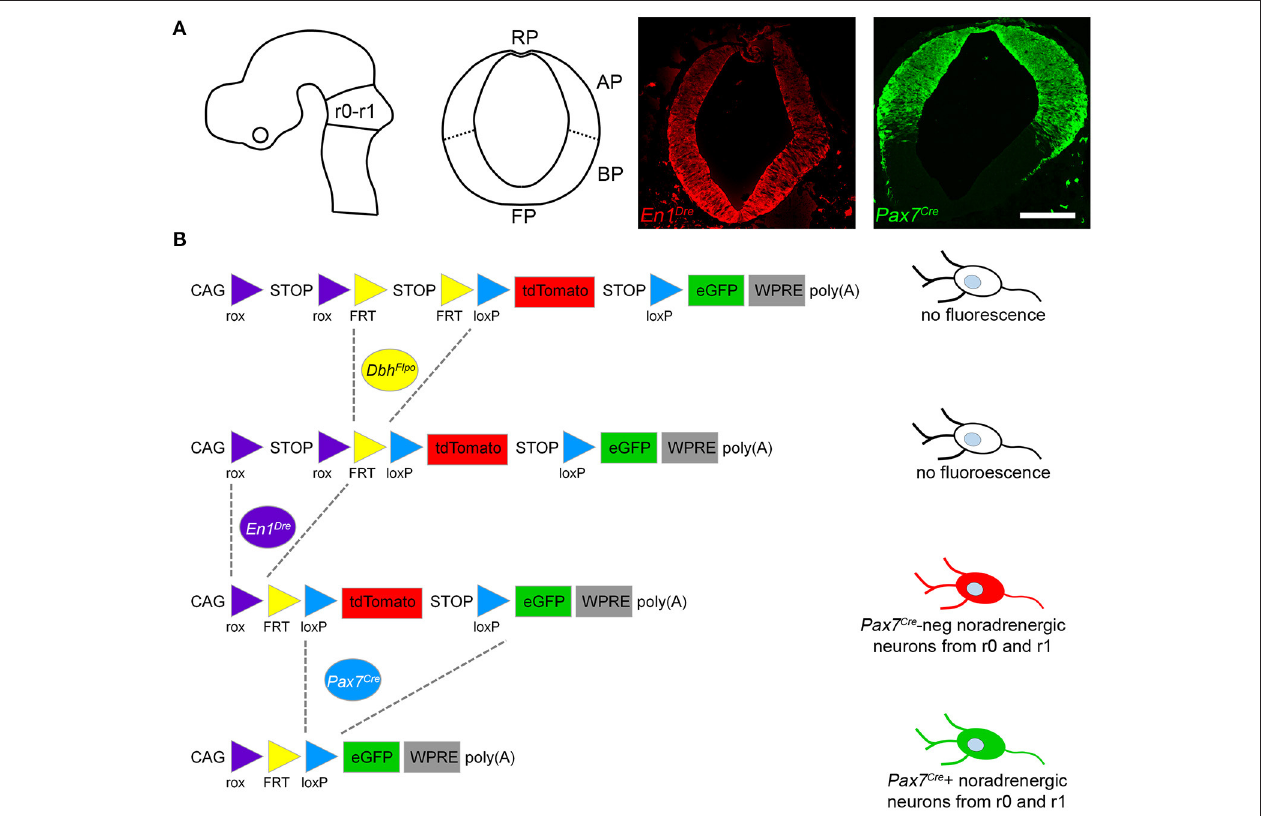
FIGURE 1 | Recombinase driver lines expressed in the embryonic hindbrain permit intersectional genetic fate mapping of noradrenergic neuron subpopulations. (A) Schematic diagrams show the mouse neural tube at E10.5 (Left, sagittal view; Right, coronal view) at the level of rhombomeres 0 and 1 (r0-r1). In E10.5 embryos a fluorescent Dre indicator reveals En1 Dre expression throughout the dorsoventral axis, while a fluorescent Cre indicator shows Pax7 Cre restricted to the alar plate (AP). BP, Basal plate; FP, floor plate; RP, roof plate. Scale bar: 200 µ m. (B) Schematic diagram of the RC::RFLTG indicator allele (Plummer et al., 2015). En1 Dre and Dbh Flpo recombinase activity deletes rox- and FRT-flanked stop cassettes, permitting tdTomato expression in noradrenergic neurons originating in r0 and r1 outside the Pax7 Cre domain. En1 Dre , Dbh Flpo , and Pax7 Cre expression deletes the stop cassettes and tdTomato, permitting EGFP expression in noradrenergic neurons from the Pax7 Cre domain of r0 and r1. Schematic does not represent chronological order of recombinase expression.